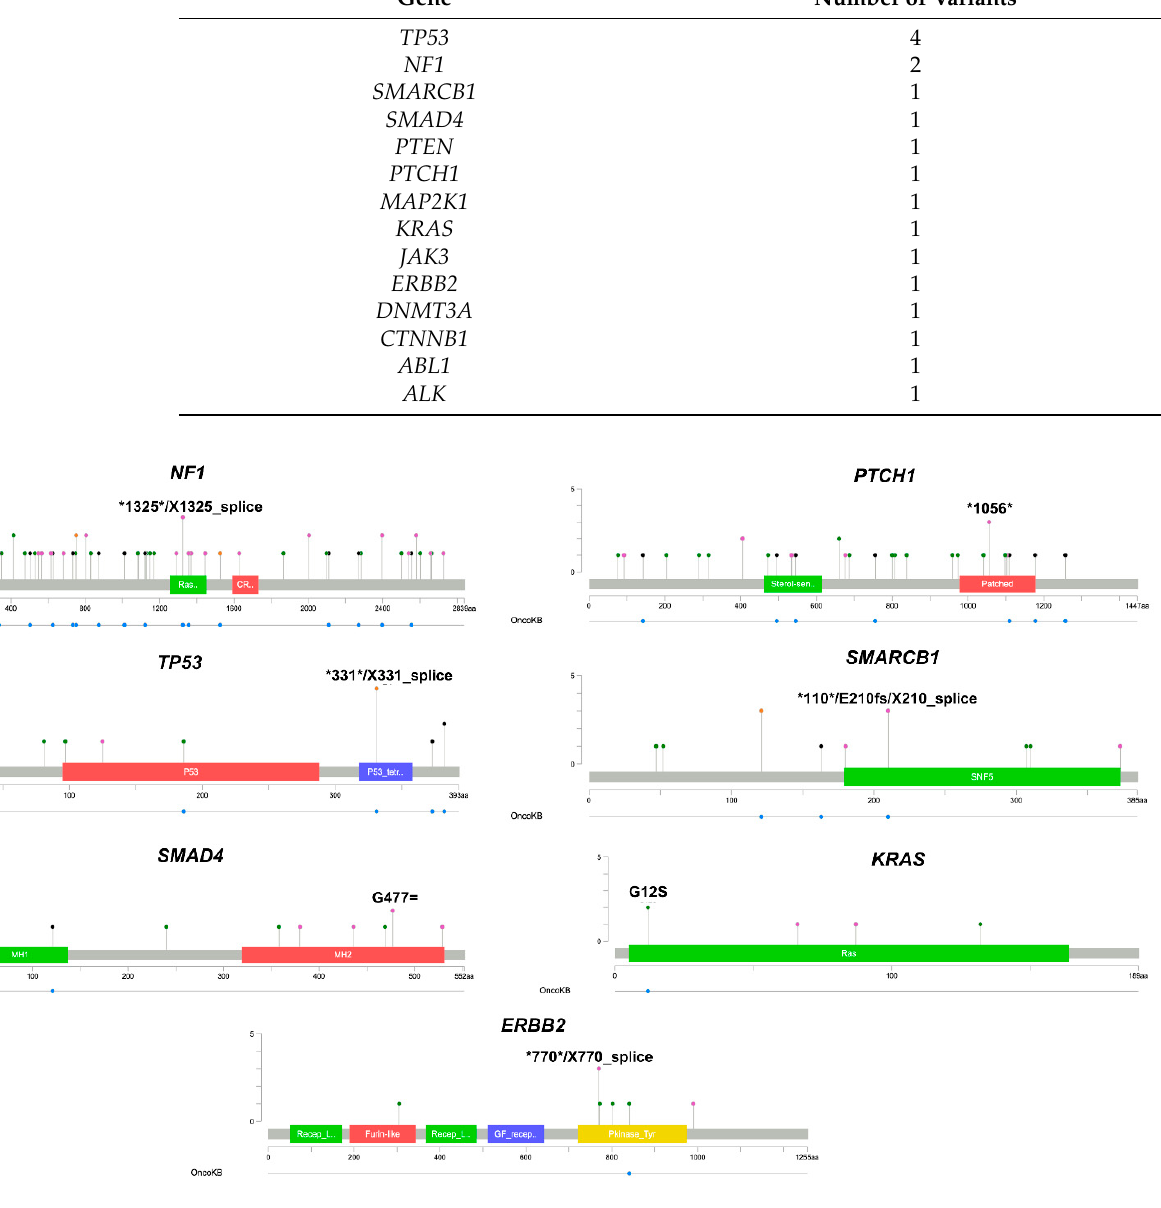
Figure 3. Gene locations of somatic variants in oncogenes and tumor-suppressor genes with predicted oncogenic impact, as per OncoKB database. Seven oncogenes/tumor suppressor genes were identified with shared somatic variants detected in ≥ 2 CTCs. Lollipop plots show the variant gene locations and their predicted oncogenic impact, according to OncoKB database. In some genes, at the same base position different mutations are observed in multiple individual CTCs. For example, in NF1 we observed a base substitution in coding sequence position of 1325 that results in the intro- duction of a stop codon and, separately at the same base position, a base substitution occurs that alters the conserved splice acceptor/donor site for exon/intron splicing. Colored boxes represent mutations in specific functional domains (*: stop codon; mutation types: green: missense, black: truncating, orange: splice, pink: others). 4. Discussion In contrast to invasive lung cancer tissue biopsies, which are associated with signifi- cant morbidities and costs, minimally invasive liquid biopsies by simple blood draws hold great promise to improve clinical management of NSCLC. Liquid biopsies in cancer pa- tients can identify somatic variants and cancer-associated mutations at the time of diag- nosis or later on in real-time to allow precise adjustments of therapy management or mon- itoring of disease progression [32]. Beyond CTC enumeration, the present study provides a technical assessment of single CTC-targeted NGS in NSCLC patients. We successfully detected and retrieved single CTCs using 7.5 mL of blood and then performed targeted NGS with a panel targeting more than 2900 hotspots in 65 genes with known cancer-as- sociations. This approach led to identification of distinct and shared variants in and across NSCLC patients’ single CTCs. Cancer-associated variants detected in single CTCs could be matched to known cancer mutations from an established oncology knowledge base. Analysis of a relatively low number of single CTCs per patient still allowed identification of key oncogene and tumor suppressor gene variants known and not yet known to be associated with NSCLC disease.